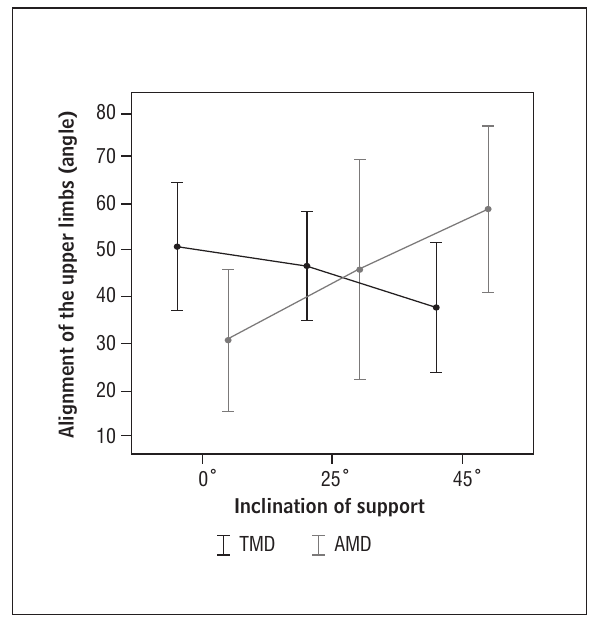
Figure 5 - Confidence interval (CI) average 95 % values of the alignment of the upper limbs during the second maximum straightening head prone with inclina- tions of 0°, 25° and 45° in the groups with typical motor development (TMD, n = 18) and atypical motor development (AMD, n =